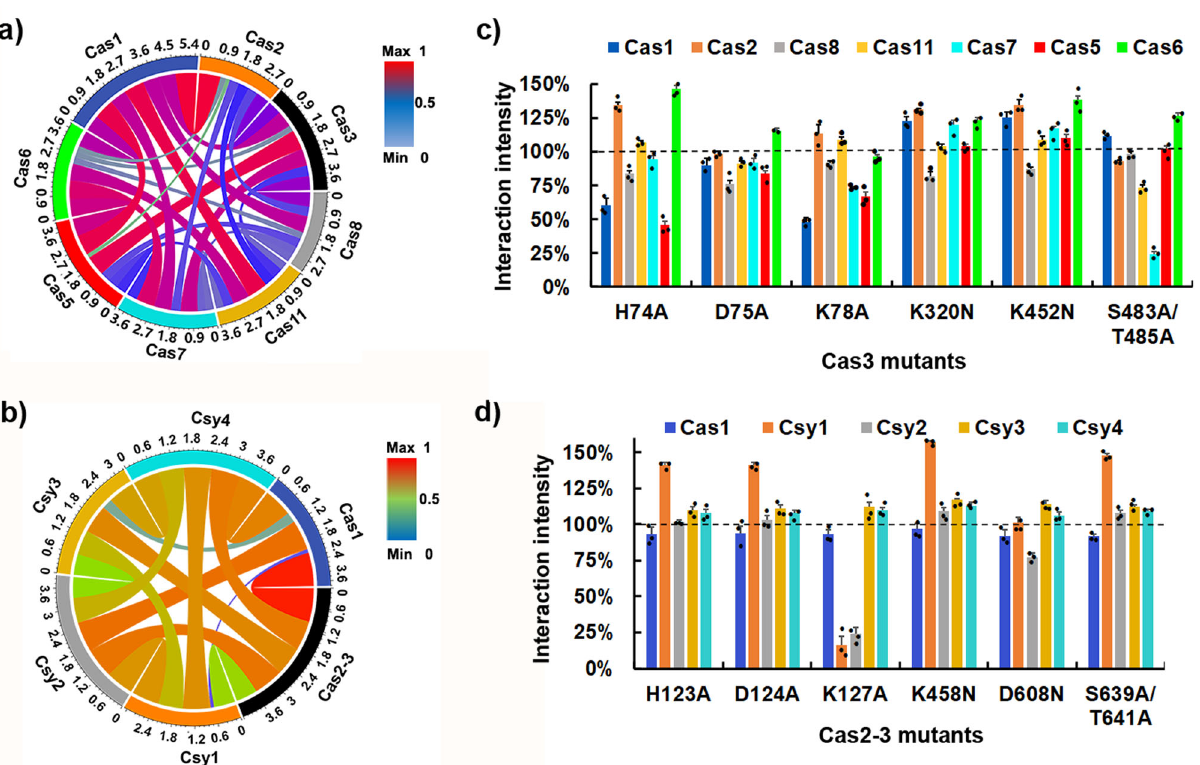
Fig. 4 Characterization of protein – protein interactions of effectors in the Type I-E and I-F CRISPR/Cas complex. a Protein – protein interactions among eight effectors (Cas1, Cas2, Cas3, Cas8, Cas11, Cas7, Cas5, and Cas6) of E. coli K12 Type I-E CRISPR/Cas complex was interpreted using the